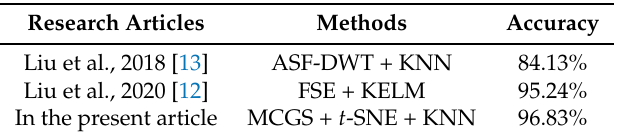
Figure 9. Confusion matrix obtained after applying t -SNE and 2-NN with LOOCV. Table 3. Comparison of achieved classification accuracy in the seven aqueous matrices multifrequency large amplitude pulse voltammetry (MLAPV) electronic tongue